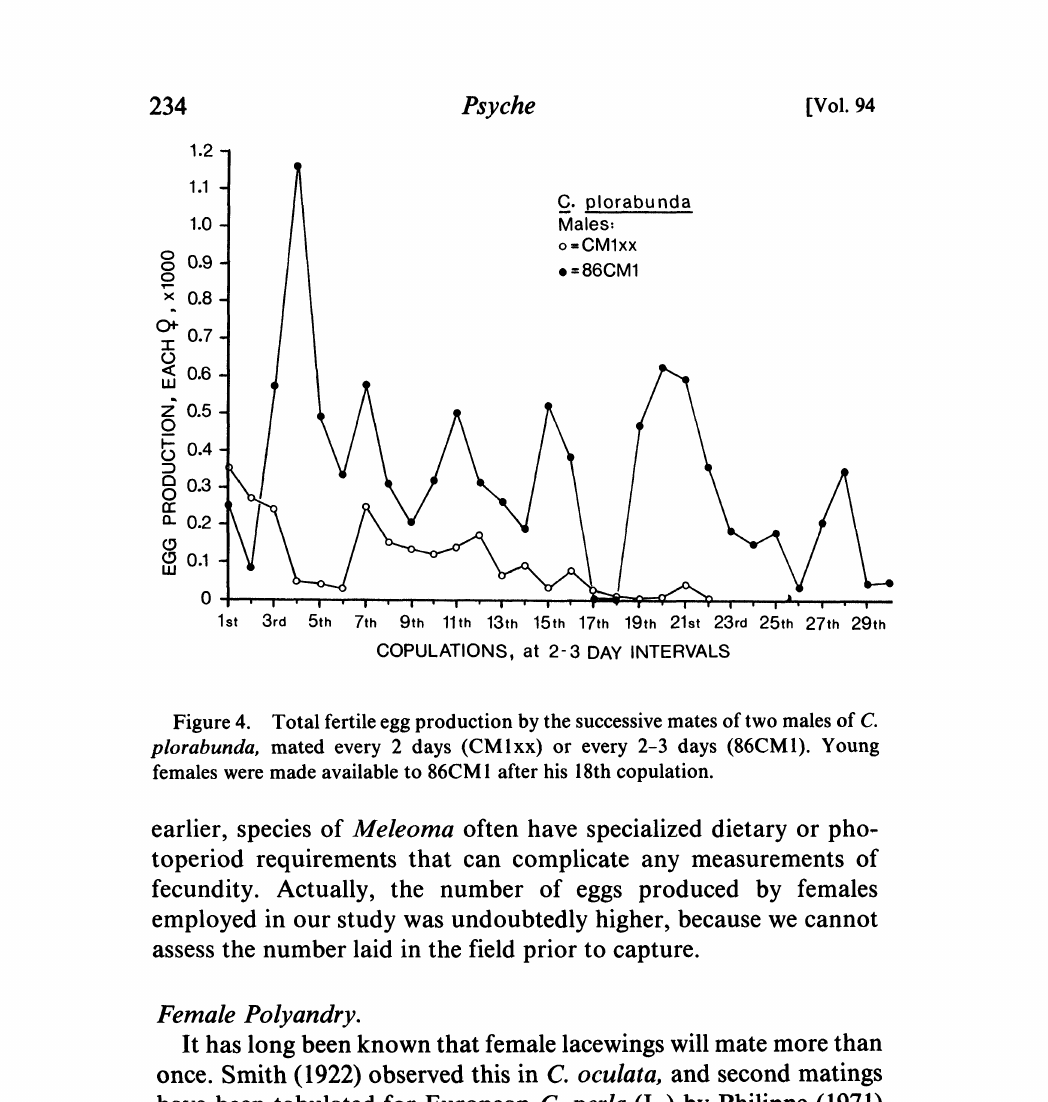
Figure 4. Total fertile egg production by the successive mates of two males of C. plorabunda, mated every 2 days (CMlxx) or every 2-3 days (86CM1). Young females were made available to 86CM after his 18th